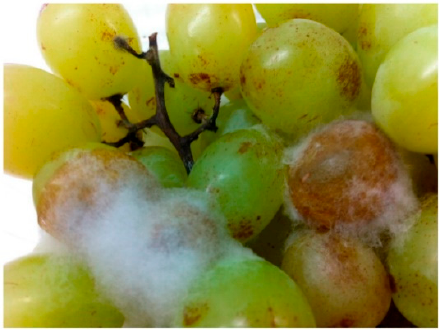
Figure 1. Effect of grey mould on cold-stored cv. “Italia” table grape berries. Image from Ahmed et al. [3].